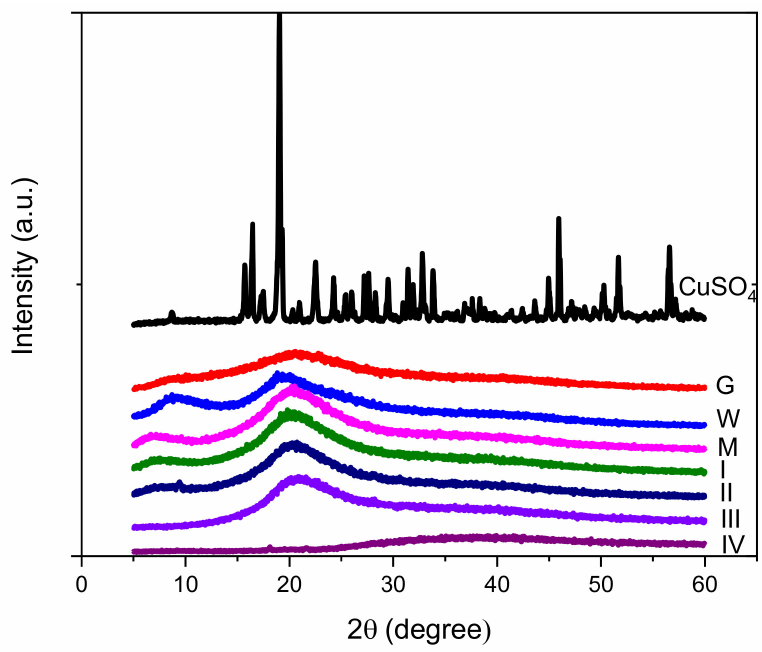
Figure 7. XRD patterns for copper sulphate, gelatin (G), whey powder (W), whey–gelatin hydrogel (M), and hydrogels containing copper sulphate (I, II, III,